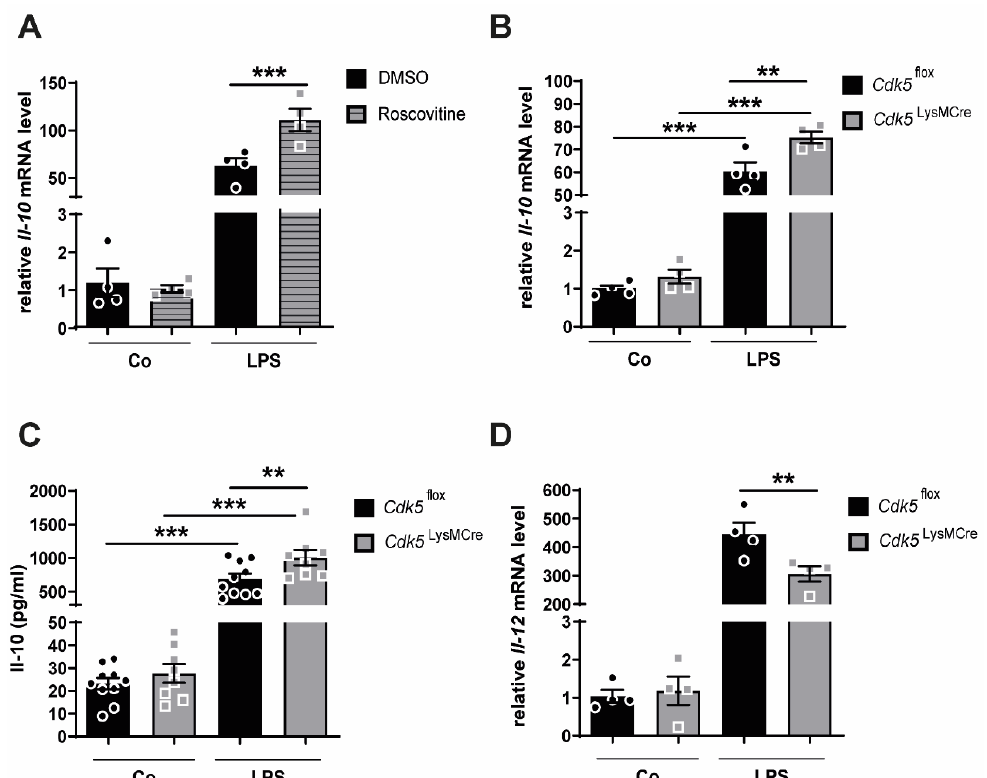
Figure 1. Inhibition or genetic deletion of Cdk5 in bone marrow-derived macrophages has an impact on the anti-inflammatory Il-10 and pro-inflammatory Il-12 response. ( A ) BMDMs derived from wild-type mice were 30 min pre-treated with 0.16 µM roscovitine, the specific concentration for Cdk5 inhibition, or DMSO (vehicle control), and then stimulated 4 h with PBS (Co) or LPS (100 ng/mL) and relative expression of Il-10 mRNA was determined by qRT-PCR. ( B – D ) BMDMs isolated from Cdk5 flox and Cdk5 LysMCre mice were stimulated with PBS (Co) or LPS (100 ng/mL) for 4 h and ( B ) relative Il-10 mRNA expression, ( C ) Il-10 secretion into the supernatant and ( D ) Il-12 mRNA expression were determined by qRT-PCR or ELISA. Results are depicted as mean ± SEM. Statistical analysis were performed by a 2-way ANOVA followed by a Bonferroni post hoc test. ** p < 0.01; *** p < 0.001. Recently, it was reported that c-Maf promotes Il-10 with an inhibitory effect on Il- 12 production [9]. Moreover, macrophages from c-Maf knockout mice showed